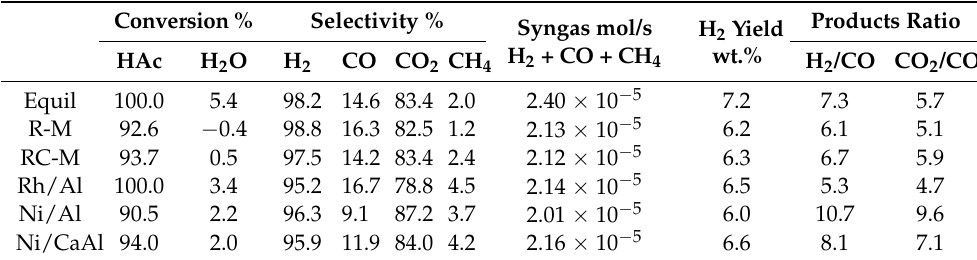
Table 5. Products selectivity and hydrogen yield obtained for ATR of acetic acid flowing at 2 mL/h,